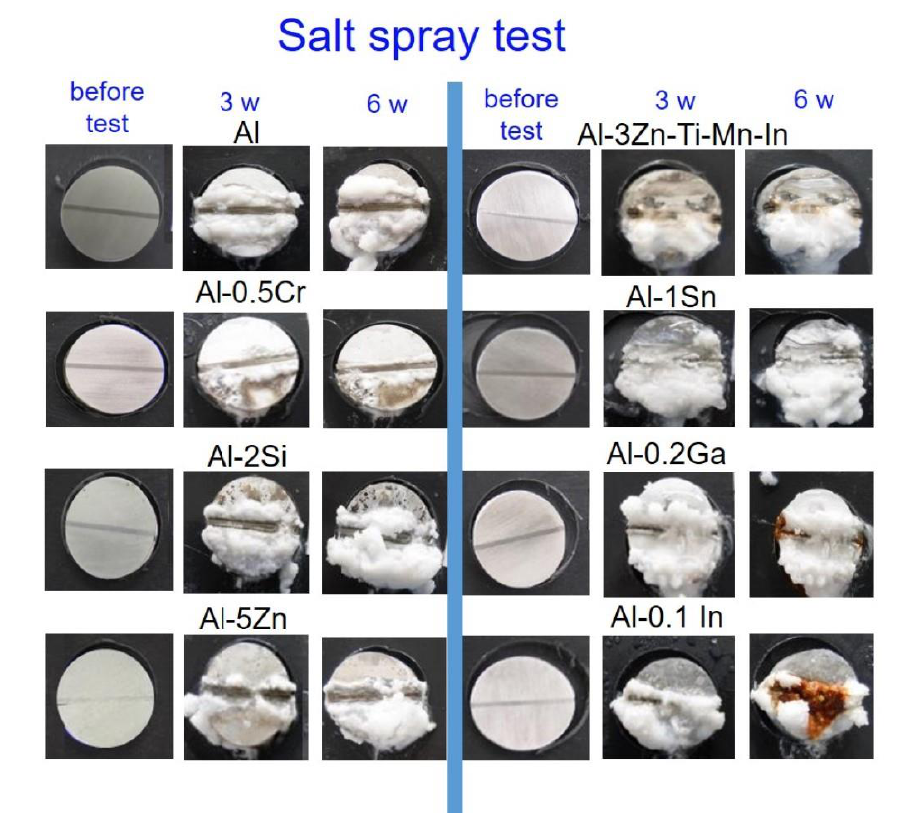
Figure 14. Images of the galvanic-coupled samples of mild-steel-Al-based alloys before testing, after 3 weeks and 6 weeks exposure in salt spray test.